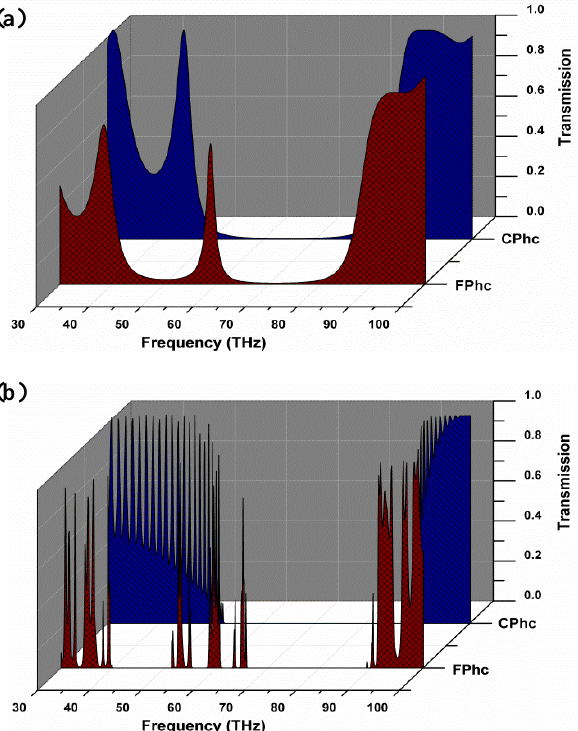
Figure 4: TE Transmittance spectrum of BiTeCl based Conventional Photonic crystal structures of (a) 5th and (b) 10th generations from 0° to 75°.